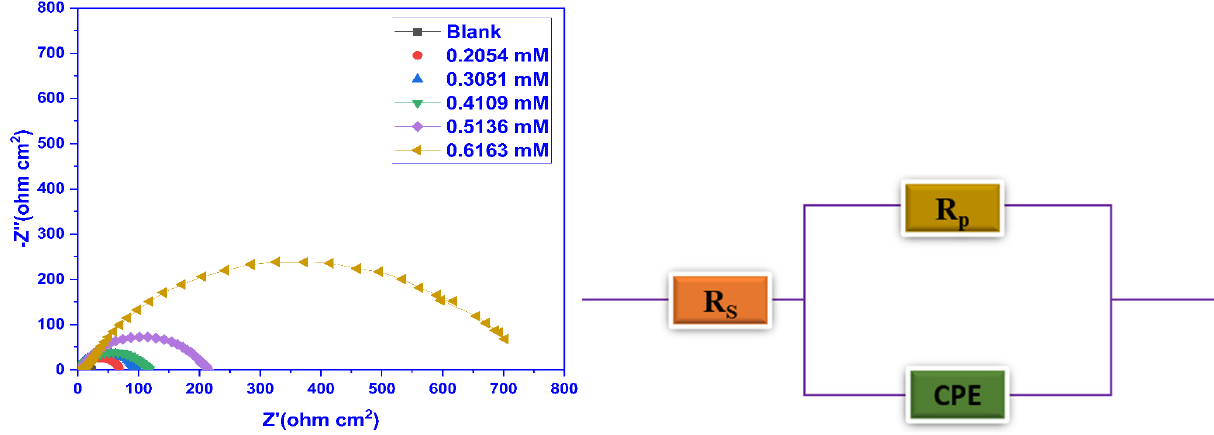
Figure 7. Nyquist plots for blank and different CMEA doses at 30 °C in 1 M HCl for MS ( Left ) and the electrical equivalent circuit employed to analyse the EIS data.